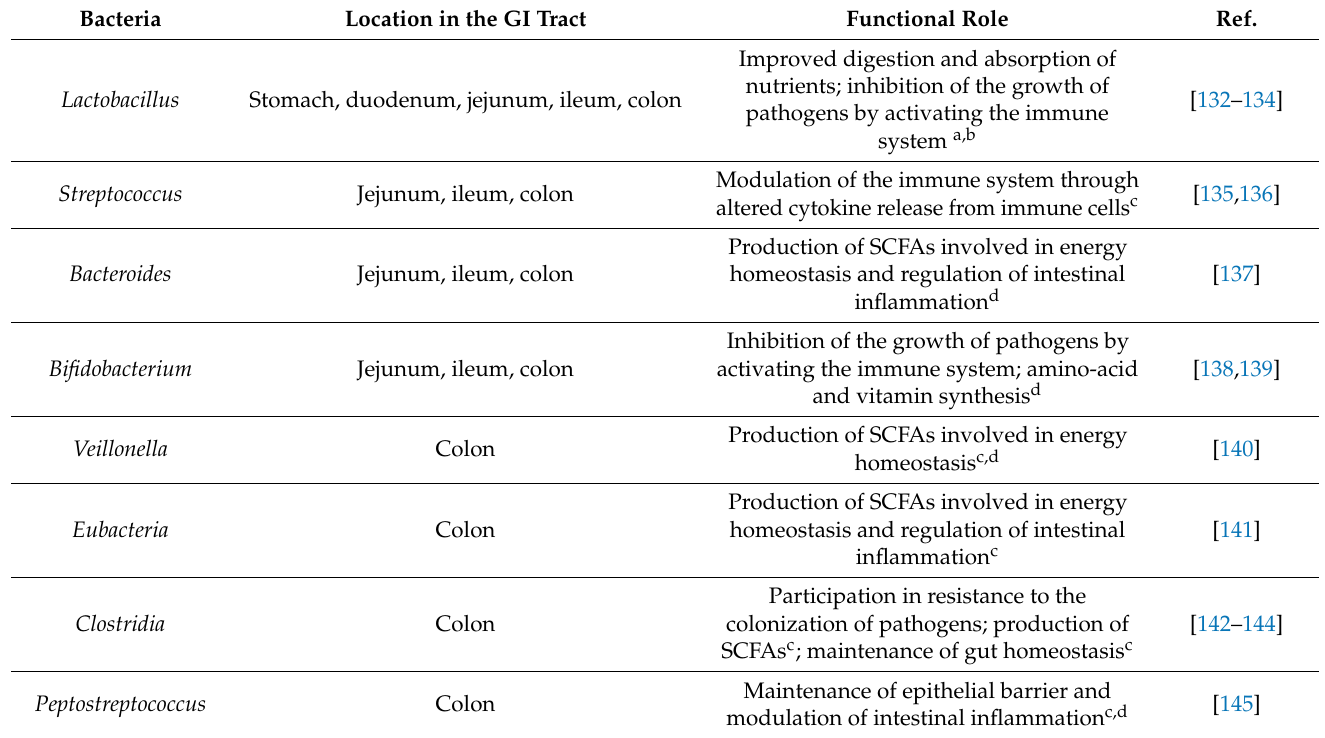
Table 3. Bacterial types, location within the gastrointestinal tract, and